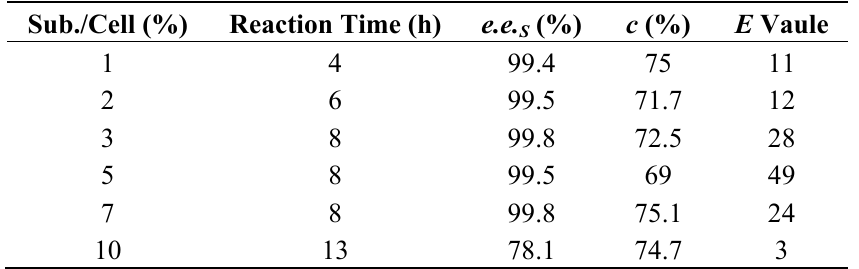
Table 2. Effect of substrate/cell ratio on enantioselectivity of epoxide hydrolase in G. geotrichum ZJUTZQ200. Reaction conditions: 1.0 g wet mycelium, 10 mL KPB (100 mM, pH 7.2), 30 °C, 200